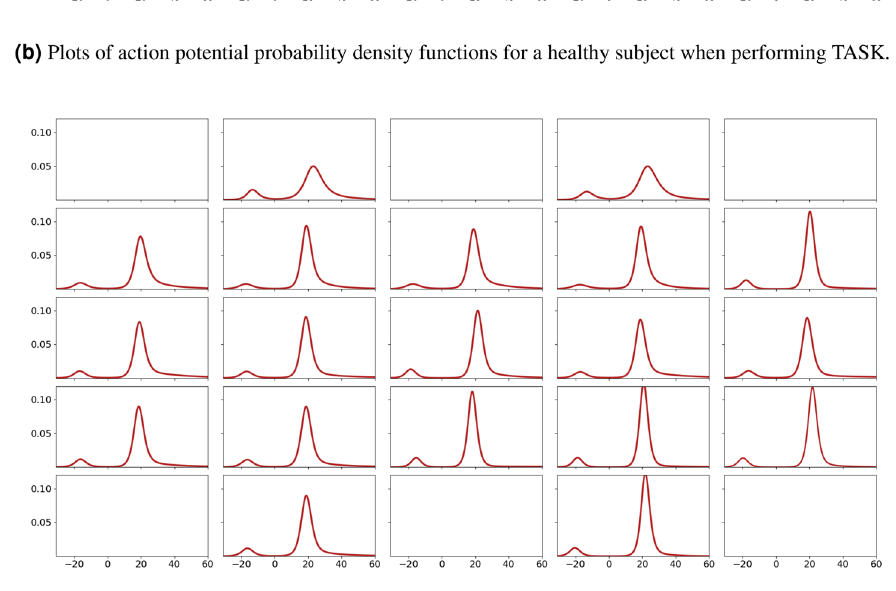
Figure 6. Schematics of electrode placement and action potential distributions for control and MDD